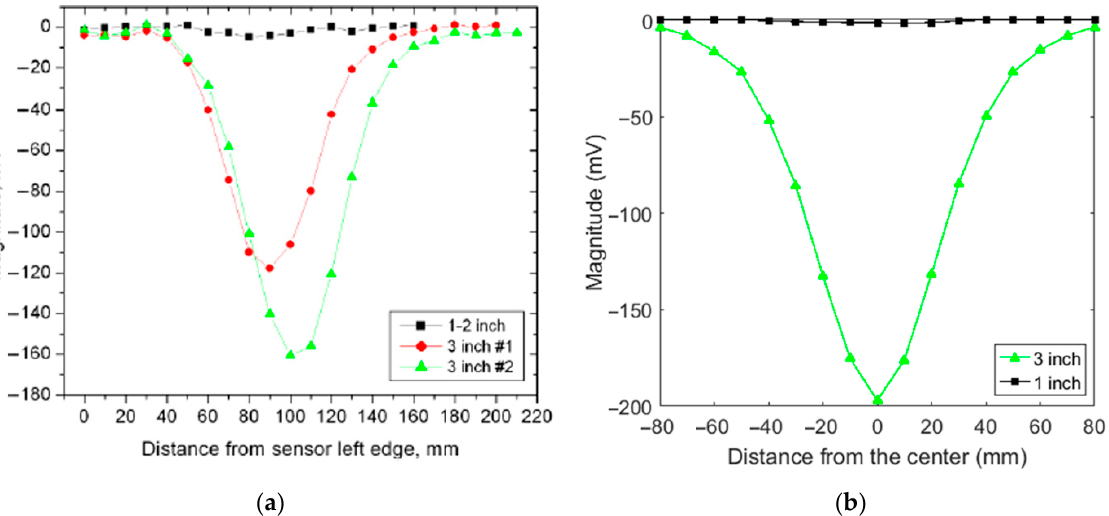
Figure 3. ( a ) Sensor response to chalcopyrite particles from experimental measurements; ( b ) Sensor response to chalcopyrite particles from simulations. Courtesy of Li et al. [37] .